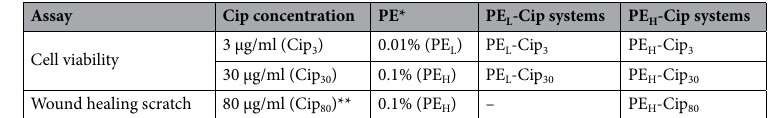
Table 1. PE-Cip treatments. *PE are CB, SA, or SH; PE L (means PE low concentration) and PE H (means PE high concentration). **Due to the greater number of cells per plate required for the wound healing scratch assay, the highest concentration of Cip that was able to dissolve in the culture medium was used 52